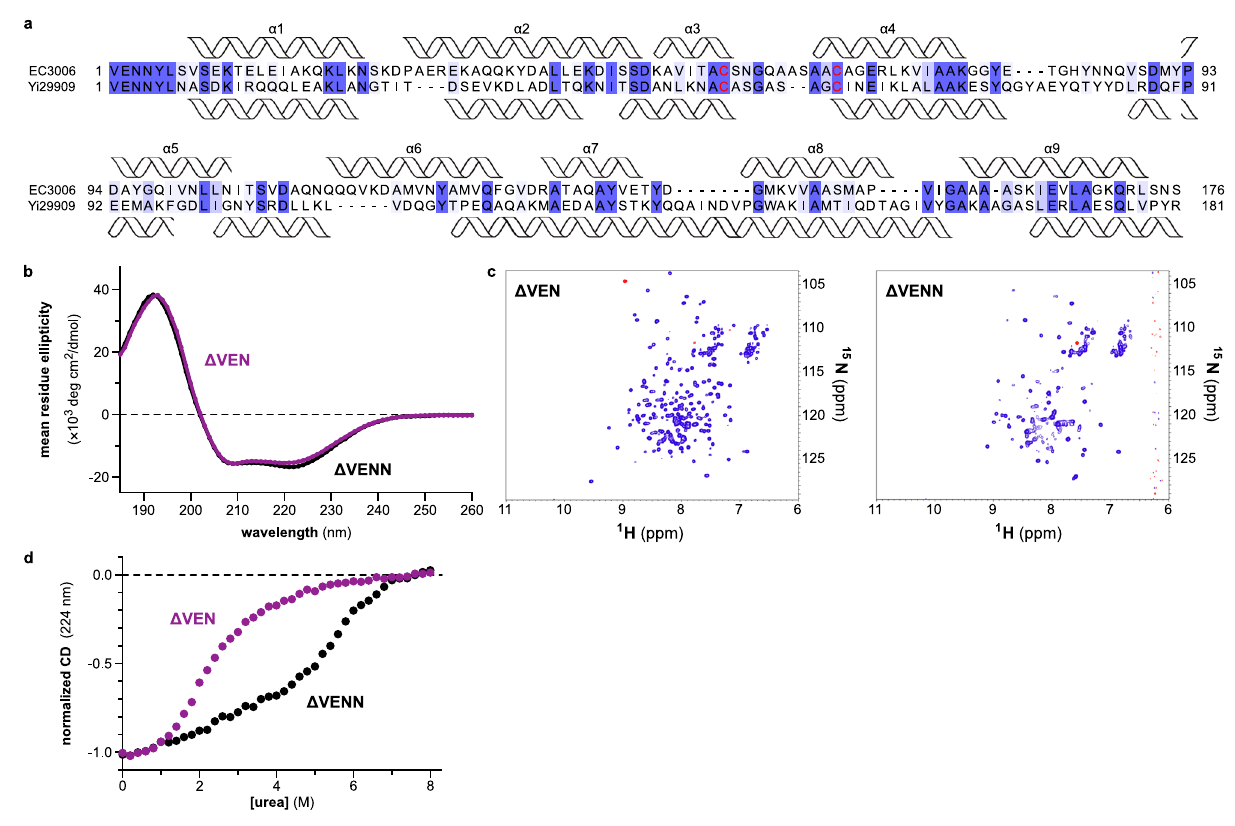
Fig. 5 | The entry domain from CdiA-CT Yi29909 undergoes a conformational switch. a Alignment of entry domains from CdiA-CT EC3006 and CdiA-CT Yi29909 . Sec- ondary structure elements below the alignment correspond to predictions CdiA- CT Yi29909 . b CD spectra of Δ VEN and Δ VENN entry domains from CdiA-CT Yi29909 .